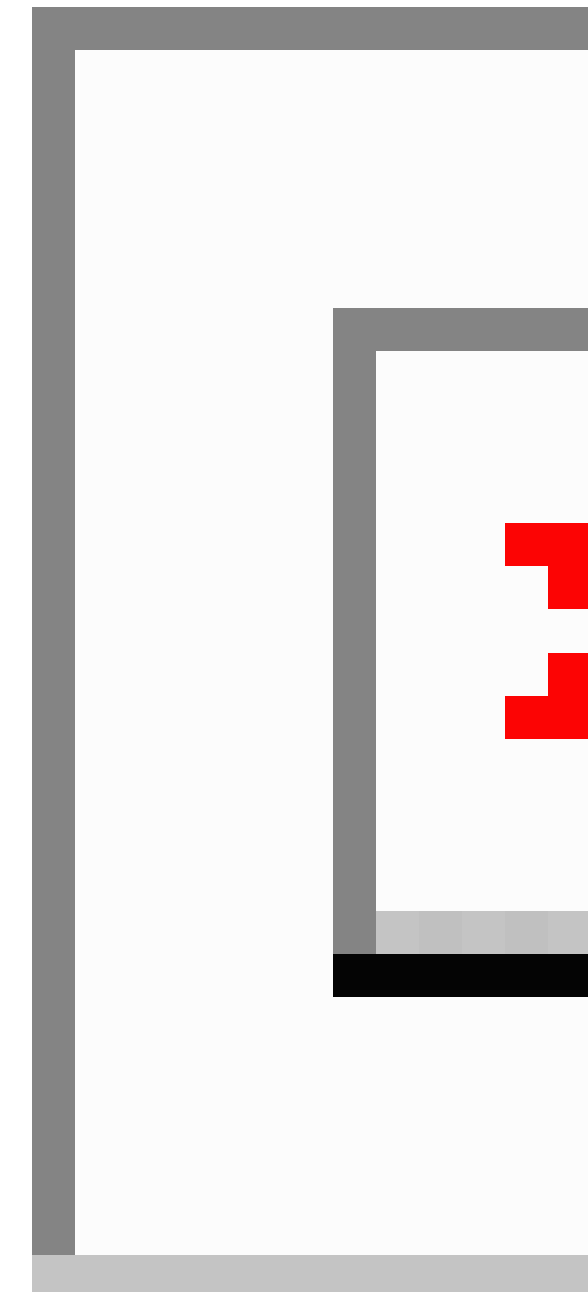
Figure 4. Enrollment flowchart for Phase